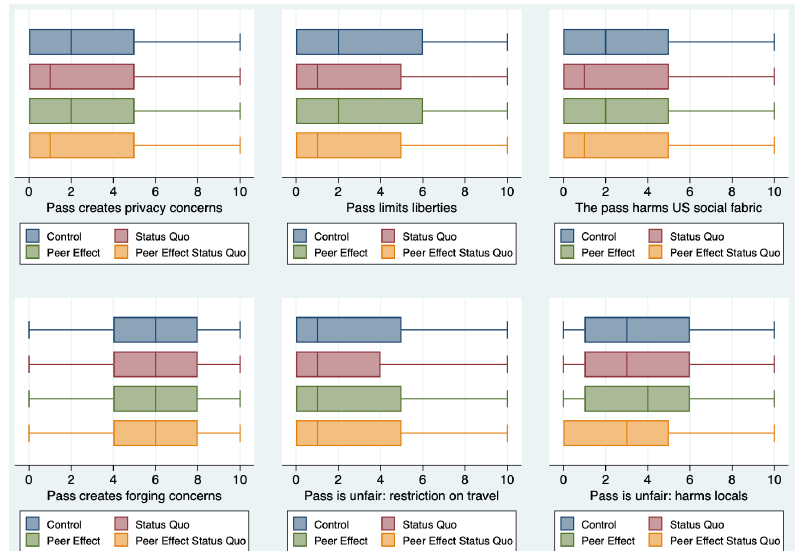
Figure 5. Summary of results for the statements meant to capture negative attributes of the COVID pass (statements 4–9). The boxplots show the distribution of responses in the Control, Status Quo, Peer Effect, and Peer Effect + Status Quo groups without any additional control. A lower value corresponds to more favorable attitudes towards the